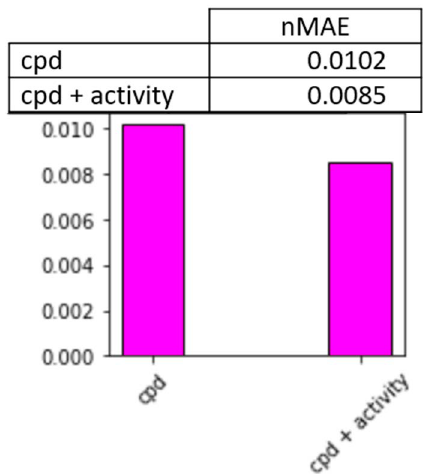
Figure 15. Normalized mean absolute error of location accuracy estimation between change points with and without activity information.